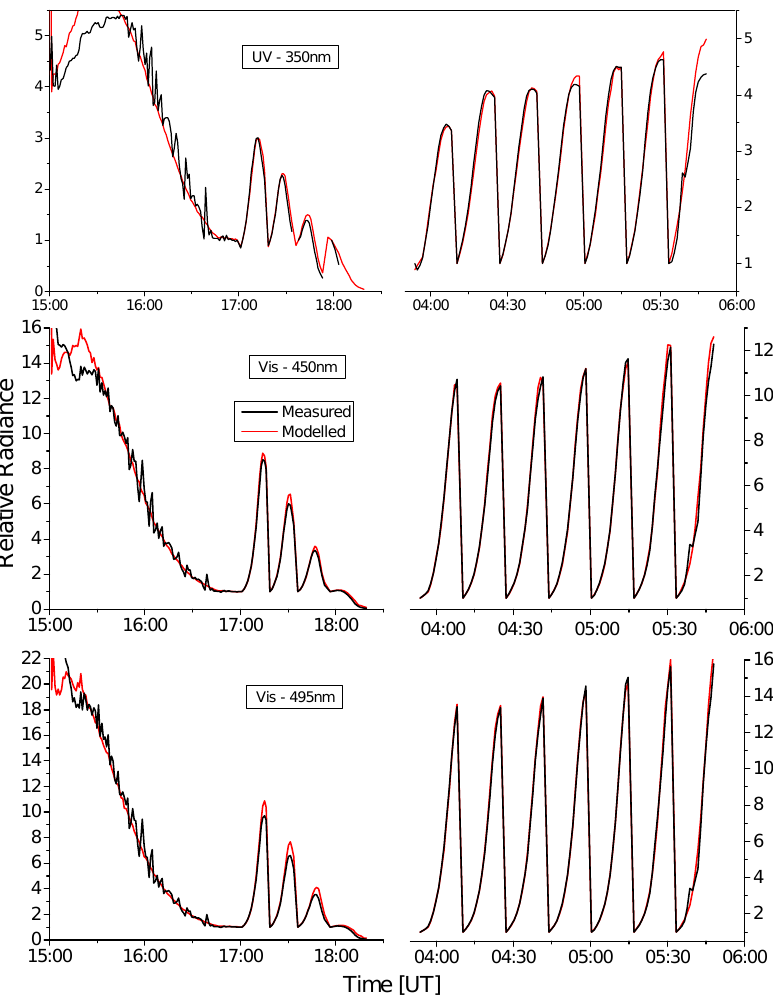
Fig. 2. Inter-comparison of measured (black) and modelled (red) relative radiances at λ = 350, 450, and 495nm for the limb scans as described in the legend of Fig. 1. The RT simulations are normalised for the balloon ascent to the observations at 17:00UT, and for each limb scan to the observation for the largest elevation angle (0 . 6 ◦ ), i.e. for the lowest